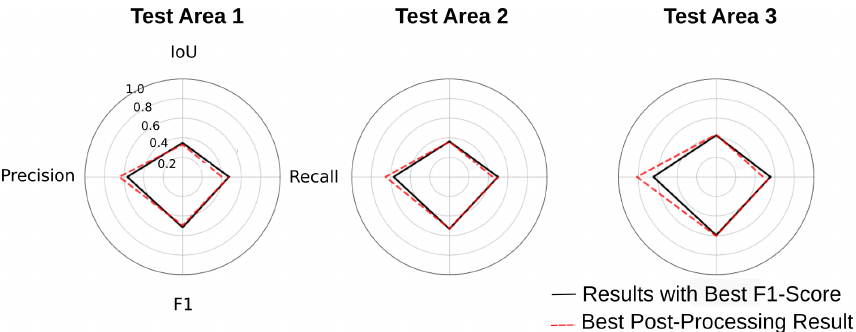
Figure 9. F1 score, recall, precision, and mIoU of the best segmentation results of each test area after the post-processing operations. The data used for the post-processing operations correspond to the prediction of the model trained with 128 × 128 pixel tiles and dataset 3 for TA1; the model trained with 32 × 32 pixel tiles and dataset 1 for TA2, and the model trained with 64 × 64 pixel tiles and dataset 1 for TA3.